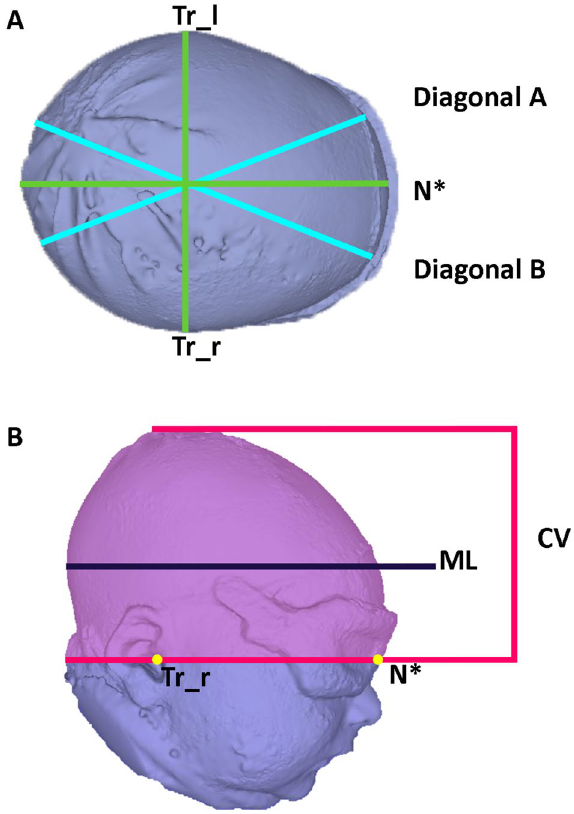
Figure 1. Clinical setting of image acquisition ( A ) during routine infant care and ( B ) while being held in the mother’s arms.